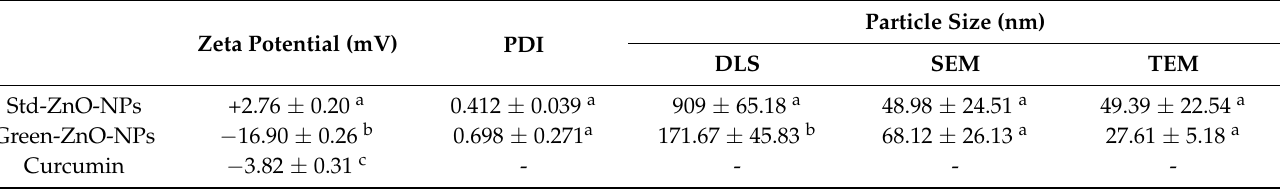
Table 1. Median hydrodynamic size, zeta potential and polydispersity index values of Green-ZnO- NPs, Std-ZnO-NPs and curcumin. Tukey post hoc multiple comparison tests show a significant difference ( p < 0.05) between samples with different superscript letters (mean ± SD; n =